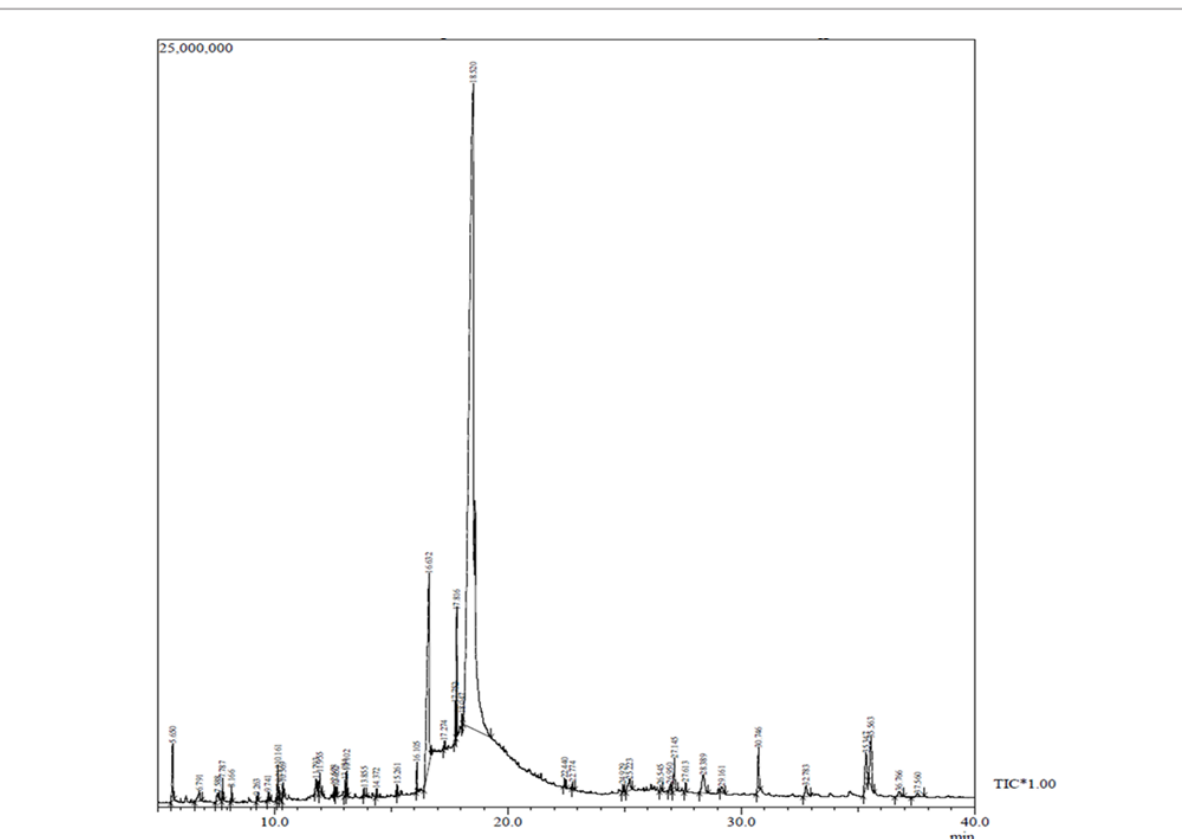
FIGURE 6 - Gas chromatography mass spectrometry (GC-MS) profile EAE of seed of N. arbor-tristis L. TABLE IV - List of phytocomponents identified by Gas Chromatography Mass Spectrometry (GC-MS) analysis of EAE of N. arbor- tristis L. seed and their bioactivity S.